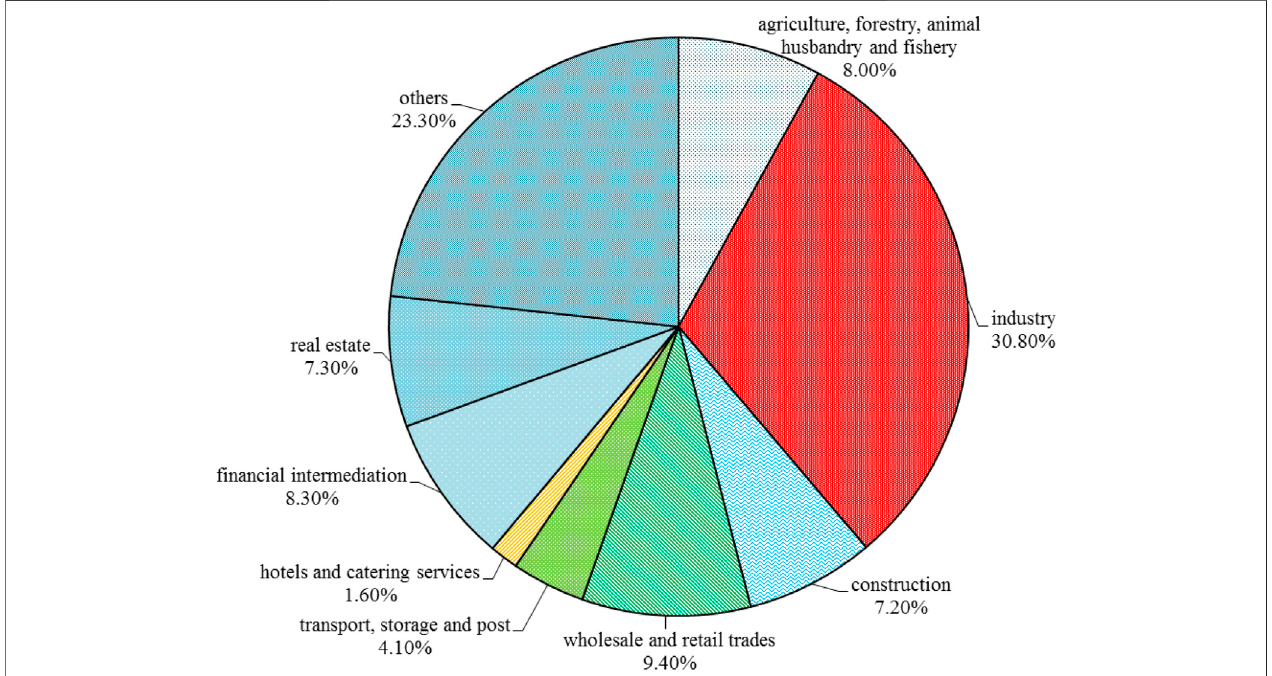
FIGURE 5 | Composition of GDP by sector in China, 2020. Source: The author searched the information from GDP Composition in the China Statistical Yearbook 2021.